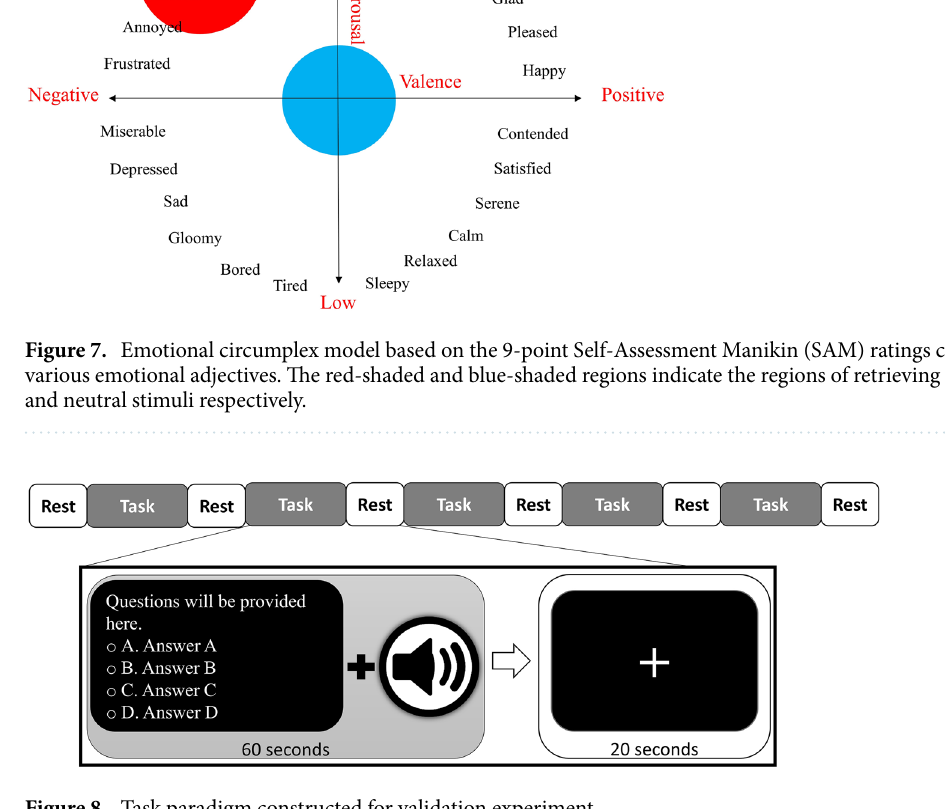
Figure 8. Task paradigm constructed for validation